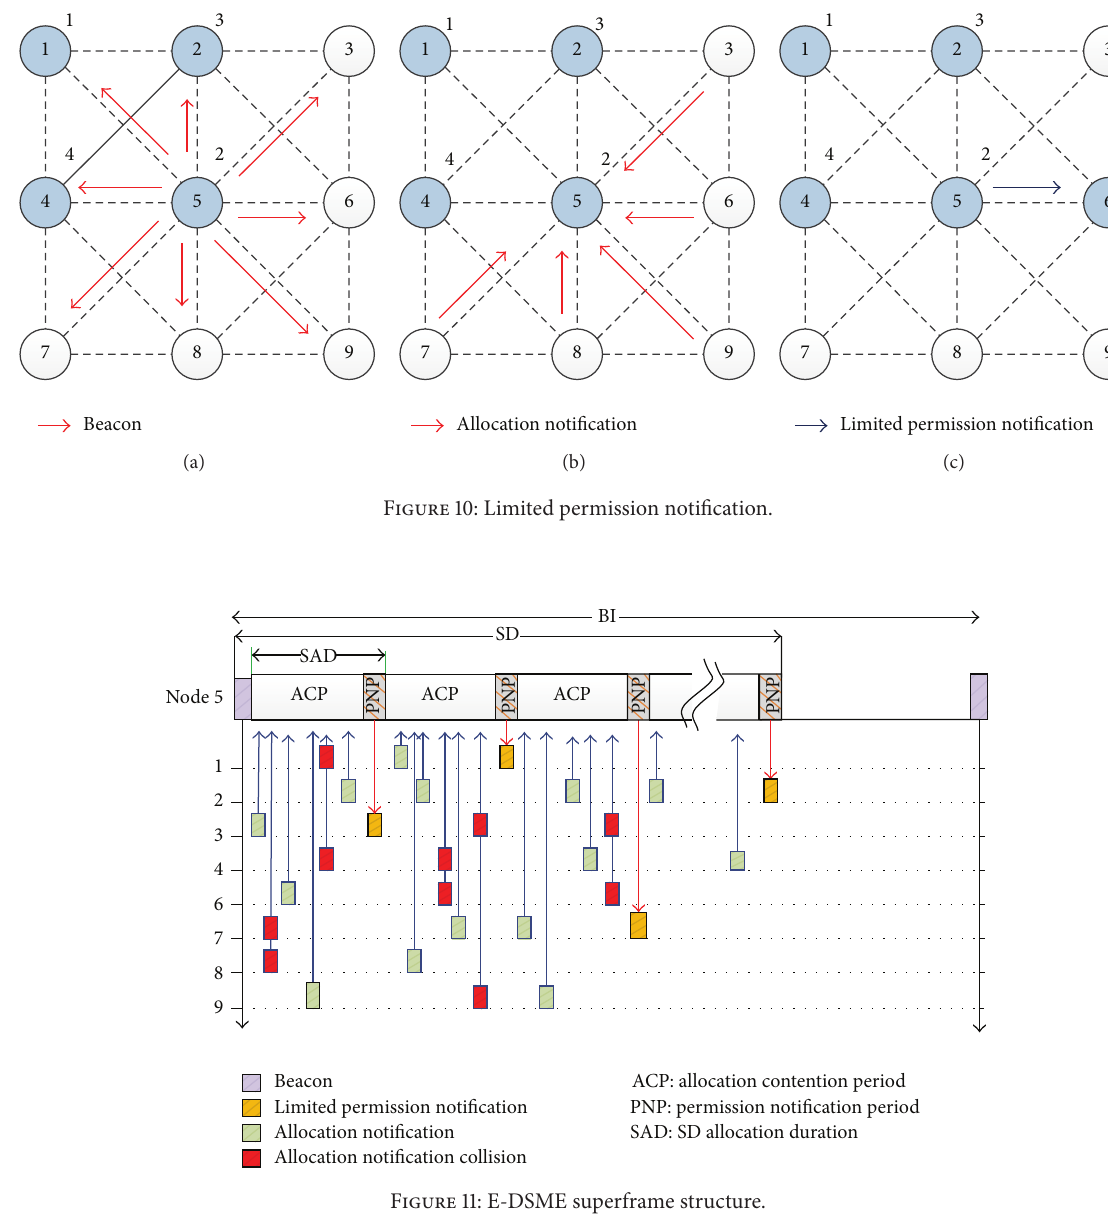
Figure 11: E-DSME superframe